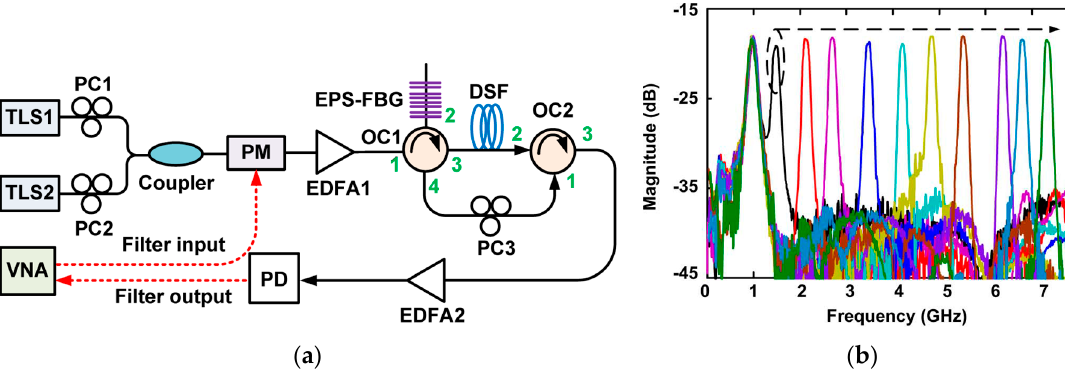
Figure 1. ( a ) Schematic diagram of the proposed dual-passband microwave photonic filter (with the courtesy of Dr. J. P. Yao). TLS(1,2): tunable laser source; PC(1–3): polarization controller; PM: phase modulator; EDFA(1,2): erbium-doped fiber amplifier; EPS-FBG: equivalent phase-shifted fiber Bragg